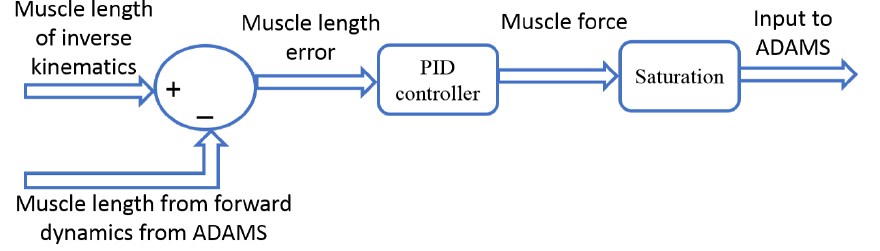
Figure 3. Feedback control scheme for calculating muscle force.